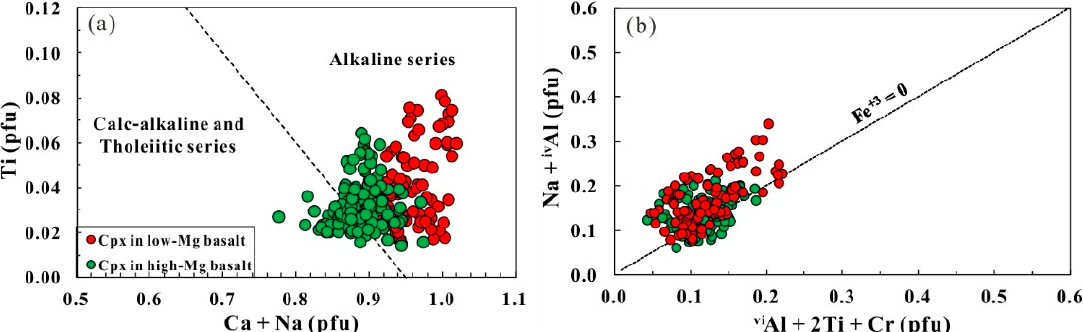
Figure 10. ( a ) Discrimination diagrams of (Ca + Na) vs. Ti (from Leterrier et al. (1982) [92]); ( b ) (A vi + Na) vs. (Al vi + 2Ti + Cr) (from Schweitzer et al. (1979) [93]).